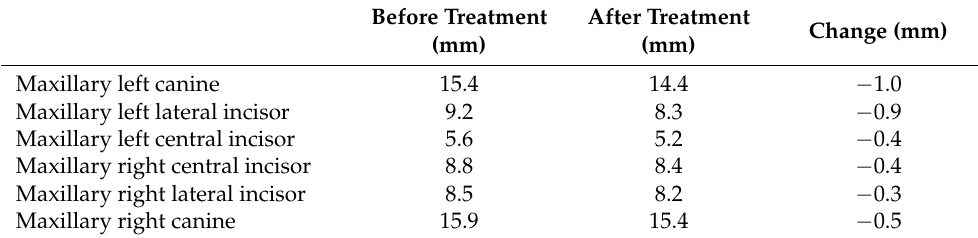
Figure 3. Pretreatment cross section images of maxillary anterior teeth. Maxillary right canine: slices #4–#8. Maxillary right lateral incisor: slices #9–#13. Maxillary right central incisor: slices #14–#18. Maxillary left central incisor: slice #19–#23. Maxillary left lateral incisor: #24–#28. Maxillary left canine: #29–#34. Table 2. Maxillary anterior teeth root length measured on